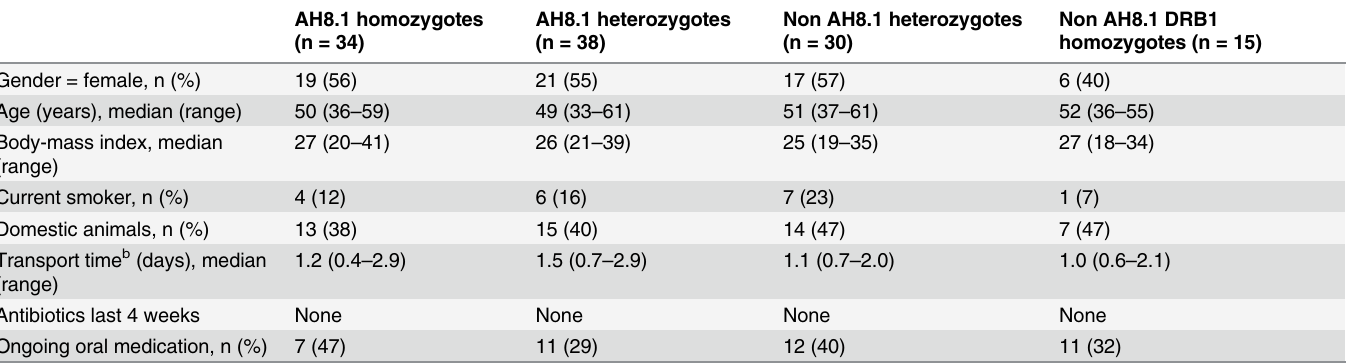
Table 2. Characteristics of the study population according to HLA genotype a